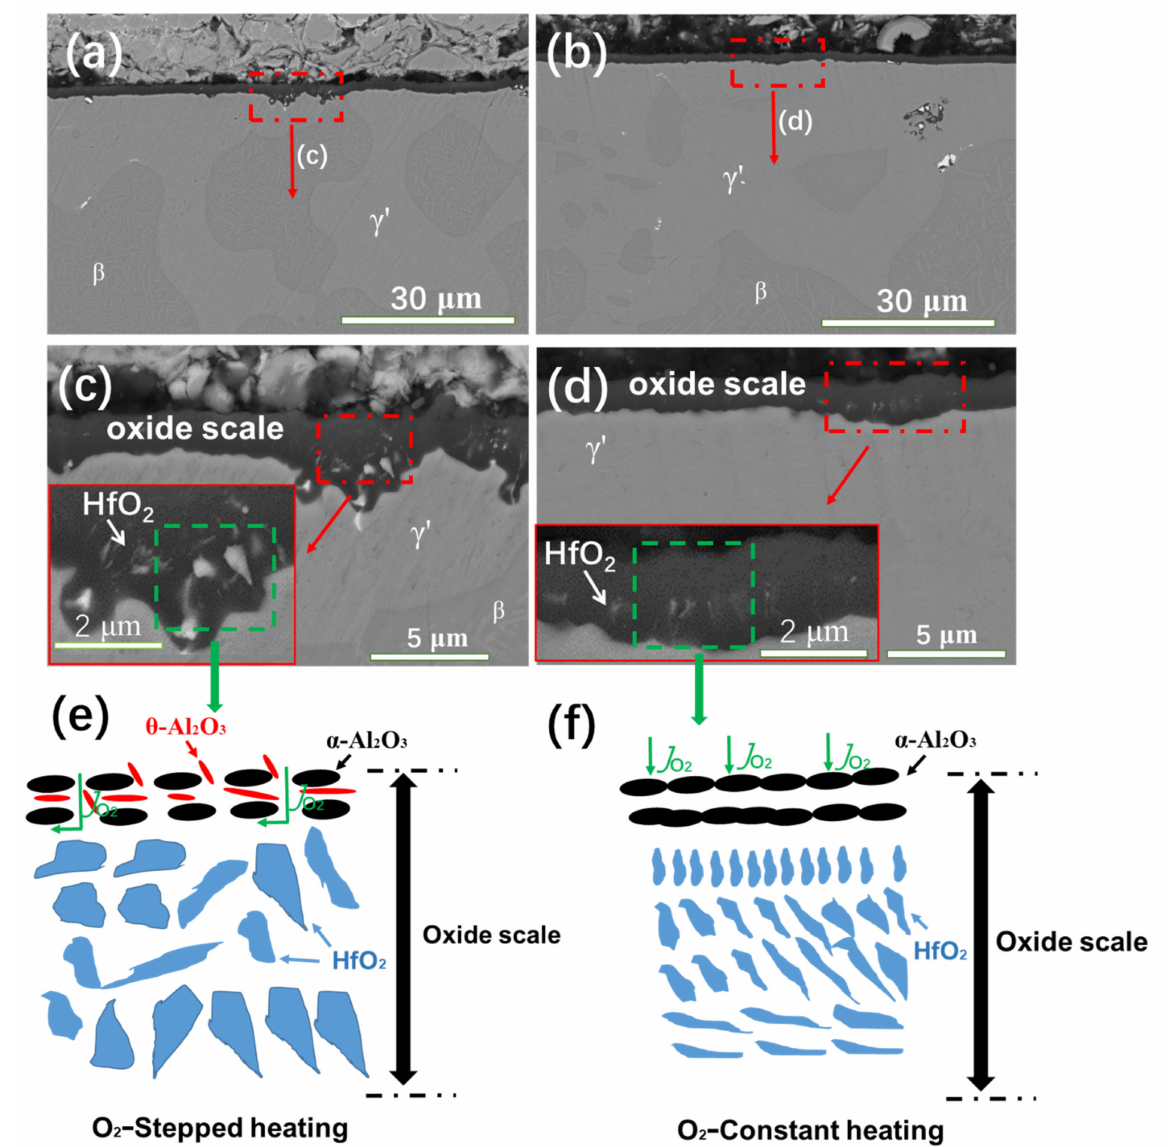
Figure 5. The cross-sectional morphologies of the oxide scale formed on the NiCrAlHf bond coat alloy after 24 h of oxidation at 1100 ◦ C in an air atmosphere: ( a ) during stepped heating; ( b ) during constant heating; ( c ) a local enlargement of ( a ); ( d ) a local enlargement of ( b ); schematic diagrams of the oxidation process of the alloy during ( e ) stepped heating and ( f ) constant